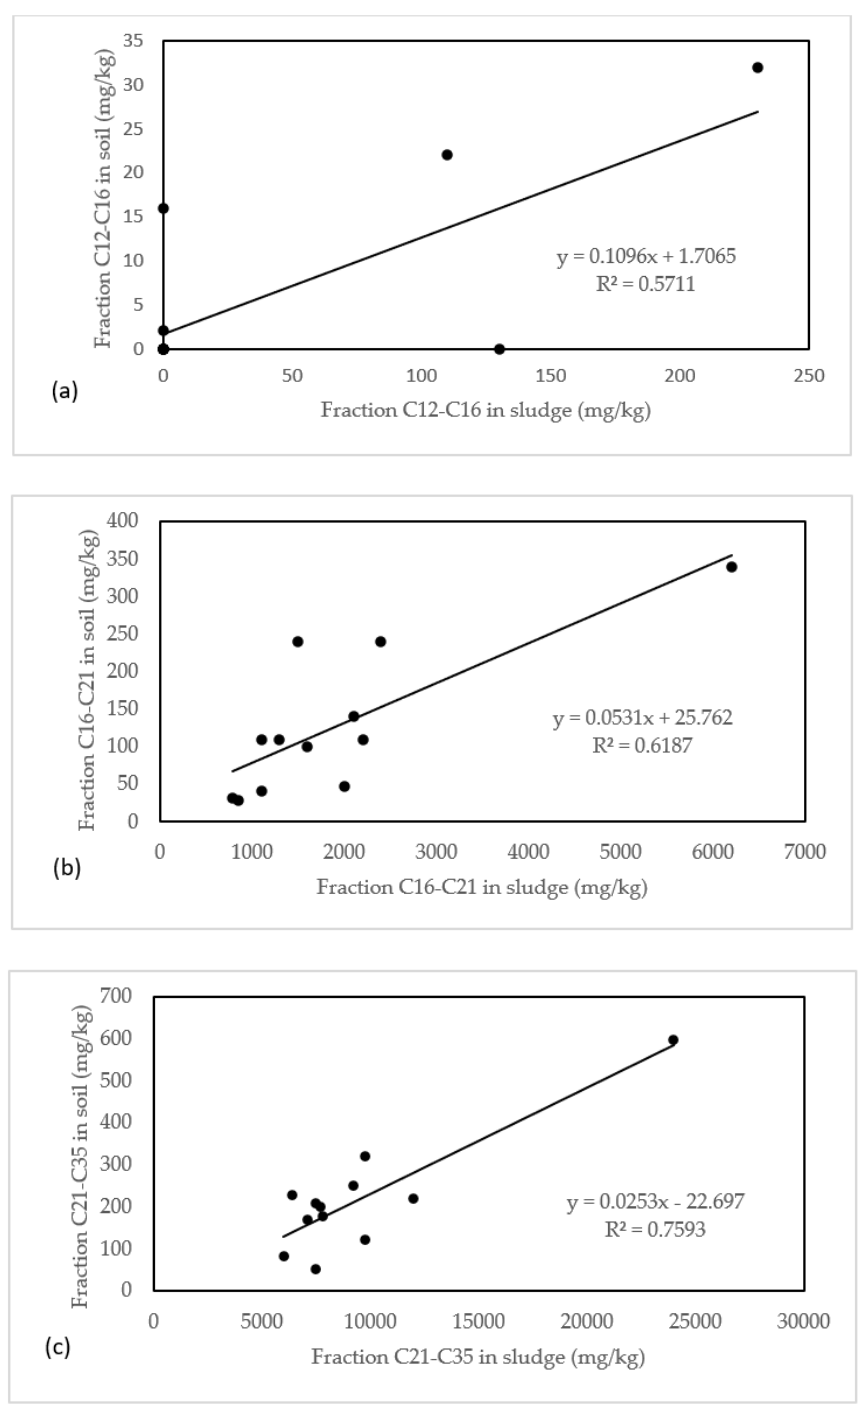
Figure 9. Relationship of aromatic fractions ( a ) C12–C16, ( b ) C16–C21, and ( c ) C21–C35 between the sludge and the surface soil.